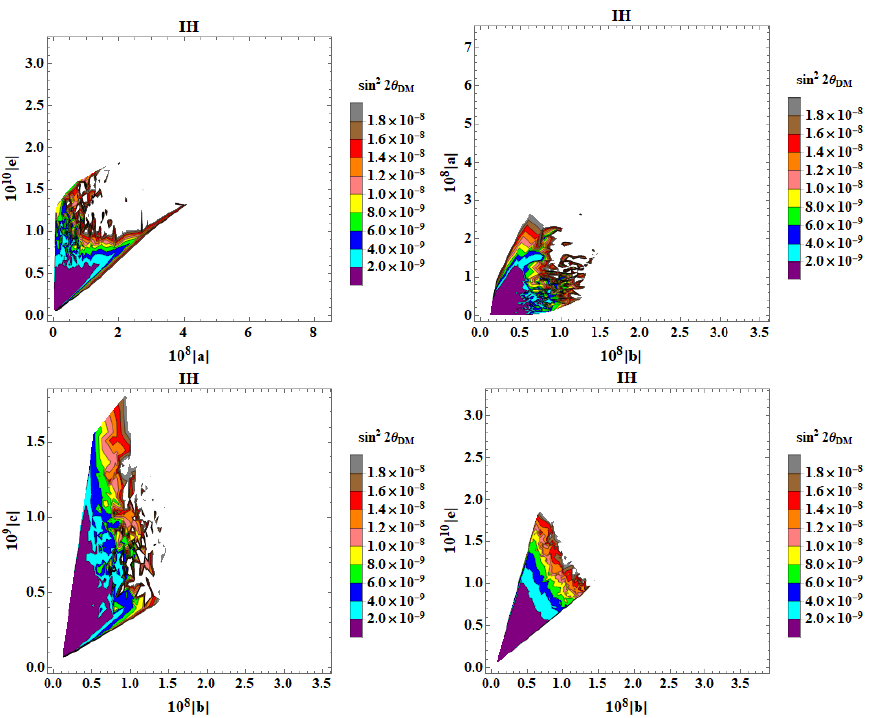
Figure 13 . Variation of di(cid:11)erent model parameters (in eV) with the DM-active mixing as the contour for inverted hierarchy. The limit as predicted by cosmology is (10 (cid:0) 12 (cid:0) 10 (cid:0) 8 ). triplets 3 and 3 0 . S and T have di(cid:11)erent structures depending on which irreducible